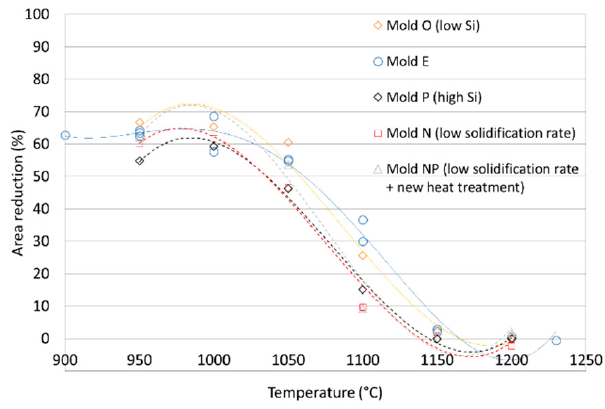
Figure 14. Comparison of on-heating curves in terms of area reduction percentage and testing temperature for moulds E, O, P, N, and NP.